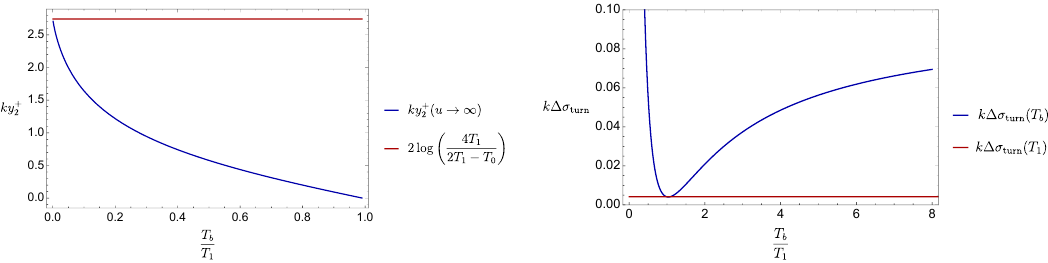
, i.e. (4.102) as the endpoint of bath 2